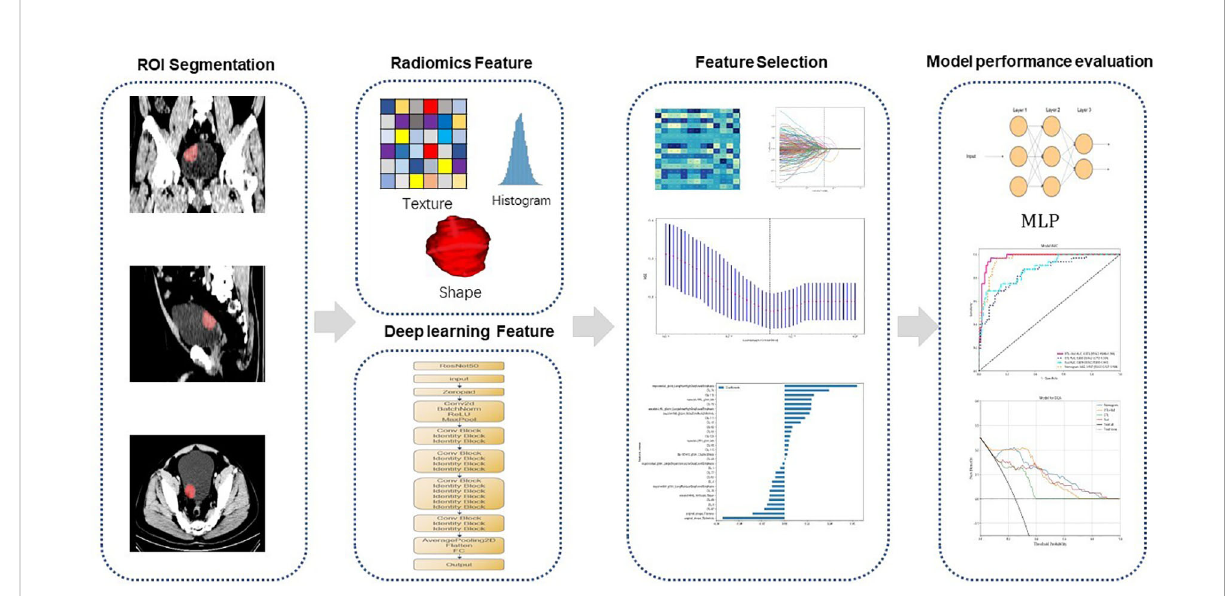
FIGURE 1 Work fl ow of our study. First, ROI segmentation is performed. Then, radiomics features and deep learning features are extracted and modeling and model test are performed. MLP Multilayer